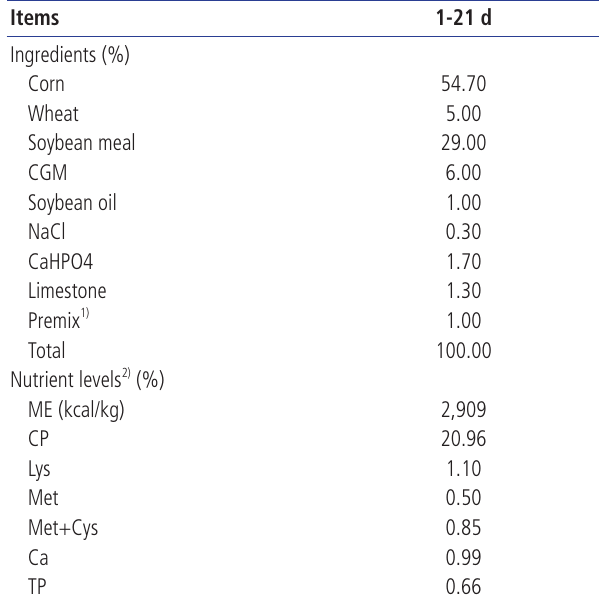
Table 1. Composition and nutrient content of the basal diet